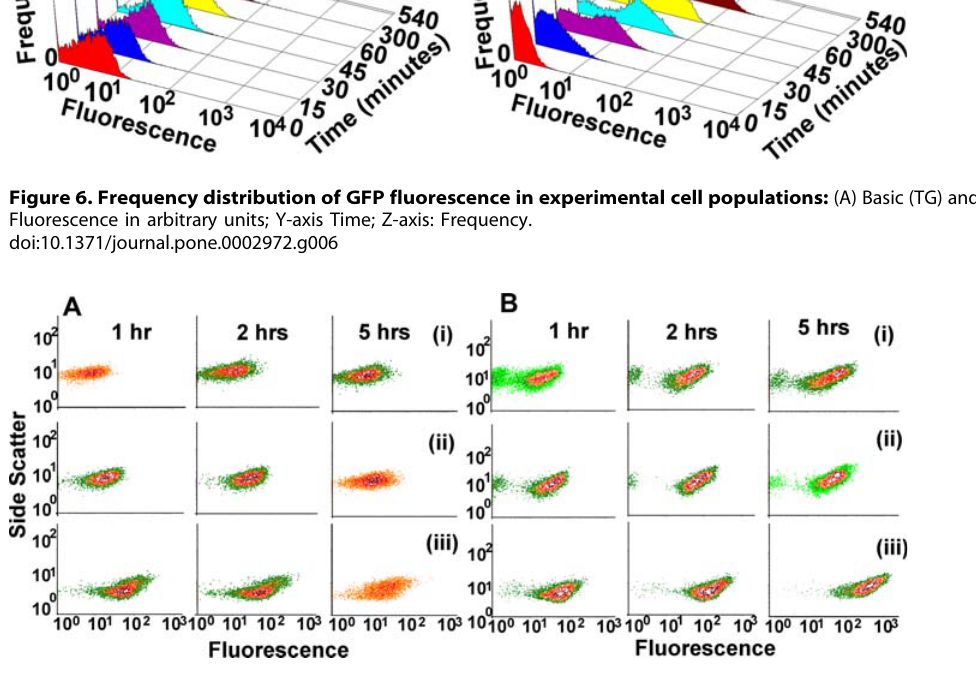
Figure 7. Contour plots of GFP fluorescence distribution: At 1, 2 and 5 hrs after induction with different inducer concentrations in cell populations of (A) TG, and (B) C2TG. Inducer concentrations-(i) 25 ng/ml, (ii) 50 ng/ml, and (iii) 75 ng/ml, of